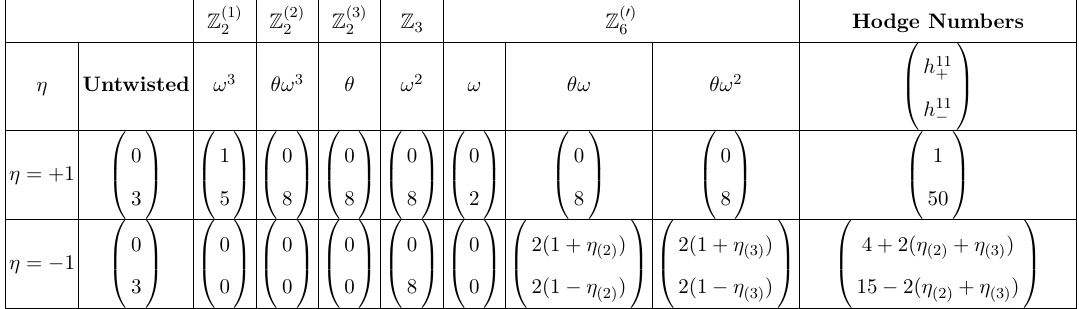
Table 4 . Splitting of the Hodge number h 11 into (cid:10) R -even and (cid:10) R -odd part on the aAA lattice. h 11 counts the number of K(cid:127)ahler moduli on the orientifold, while h 11 (cid:0) string vectors. The models in sections 3 and 4 obey (cid:17)